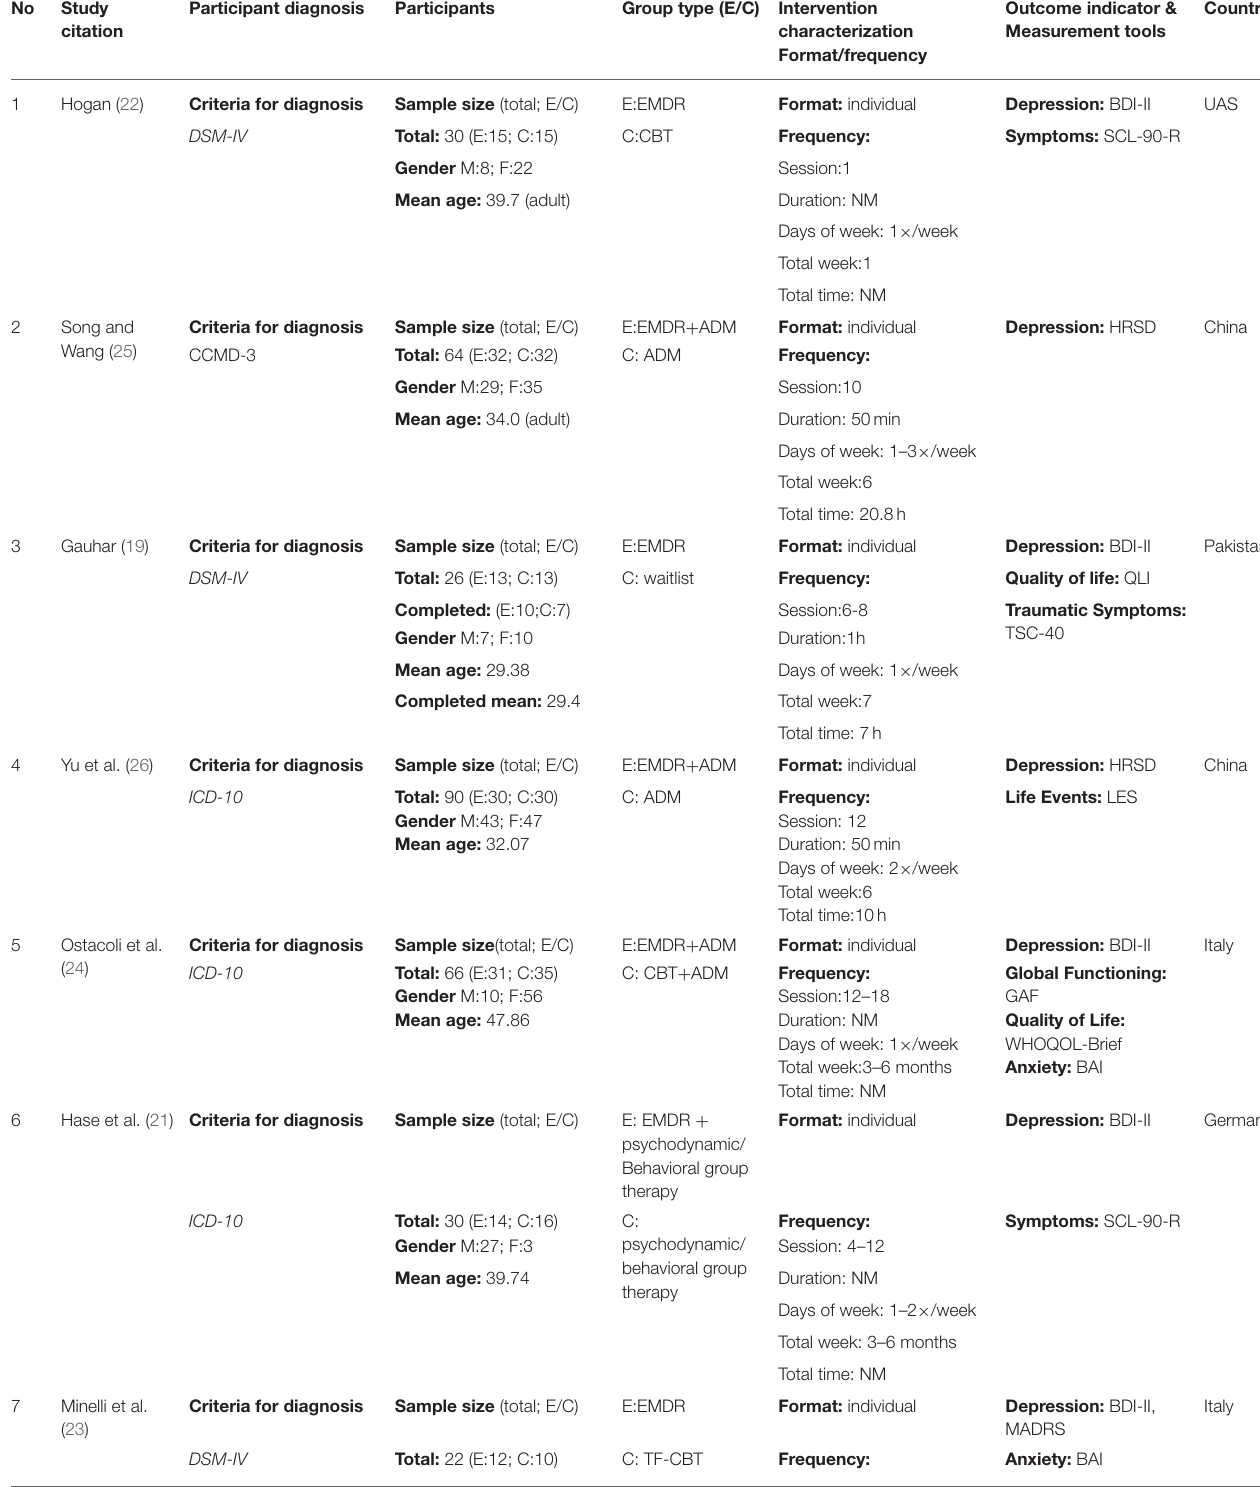
TABLE 1 | Characteristic of randomized controlled trials (RCTs) included in the meta-analysis ( N =